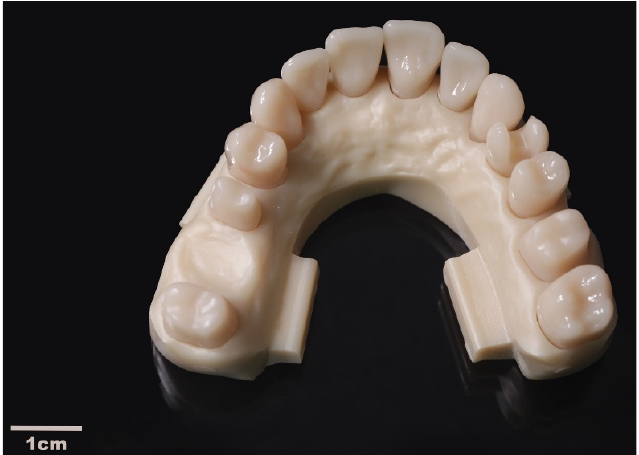
Figure 1. Reference cast with an yttrium-stabilized zirconium oxide base and lithium disilicate glass- ceramic teeth; prepared surfaces of the teeth were non-glazed. glass-ceramic teeth; prepared surfaces of the teeth were